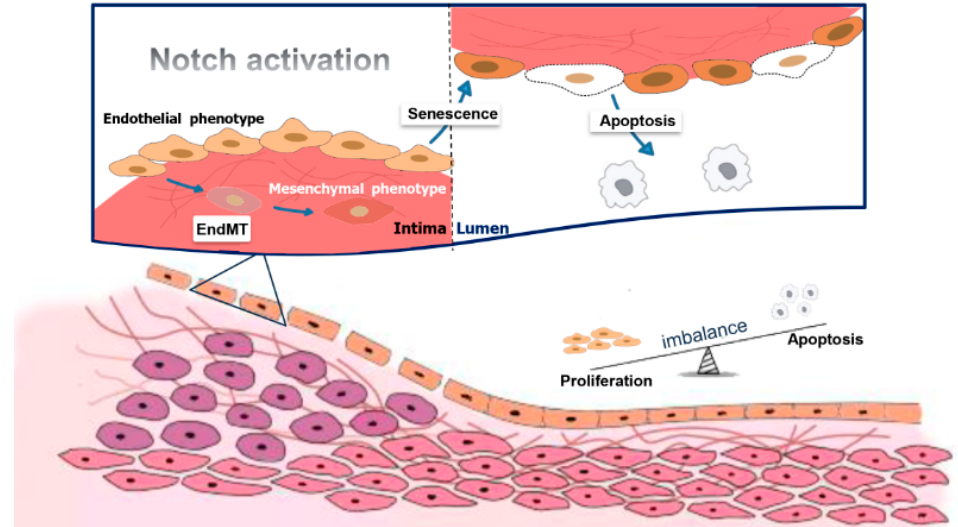
Figure 4. Endothelial cell (EC) dysfunction caused by Notch signaling leads to neointimal hyperplasia. When vascular injury occurs, Notch signaling is activated, which further triggers EC phenotype change and causes EC dysfunction. In these processes, ECs acquire the senescent phenotype, the apoptotic phenotype or the mesenchymal phenotype and lose their barrier function, which leads to endothelial hyperpermeability, leakage and inflammatory responses. Furthermore, vascular smooth muscle cell -like cells can transmigrate into the media and proliferate, resulting in neointimal hyperplasia. As mentioned above, activation of Notch-2 induces EC apoptosis while Notch-4 plays a protective role [39,43]. In arterial ECs, pro-inflammatory cytokine TNF- α elicits a switch in Notch expression, which is characterized by Notch-2 predominance over Notch-4. The events lead to a reduced